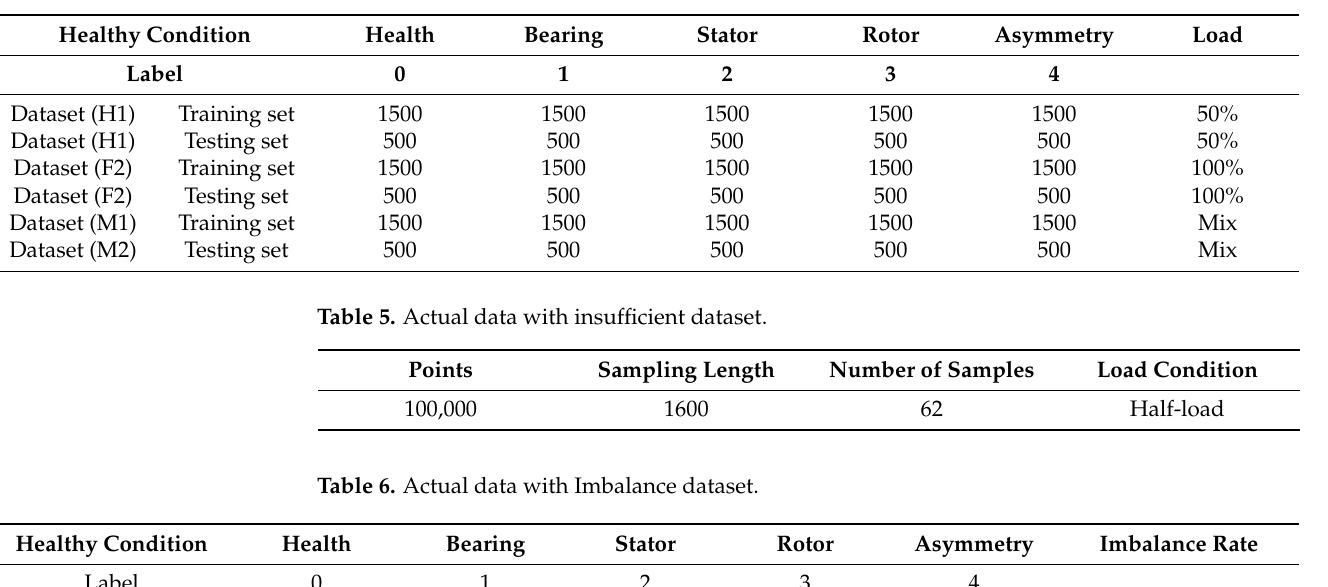
Table 4. Actual data with sufficient dataset.